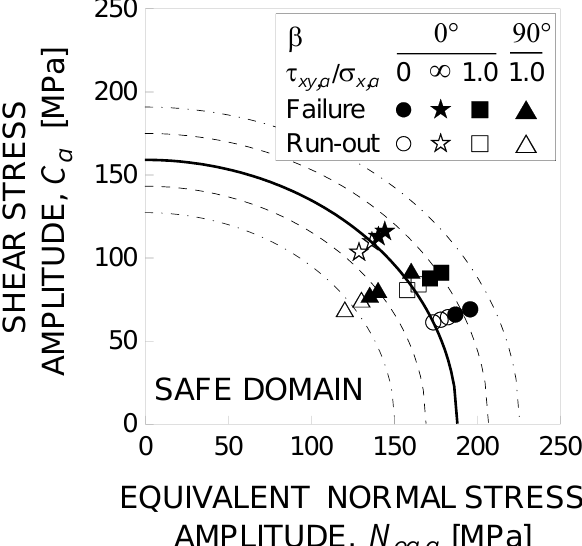
Figure 3. Shear stress amplitude vs. equivalent normal stress amplitude acting on the critical plane for EN-GJS-400-18 DCI.